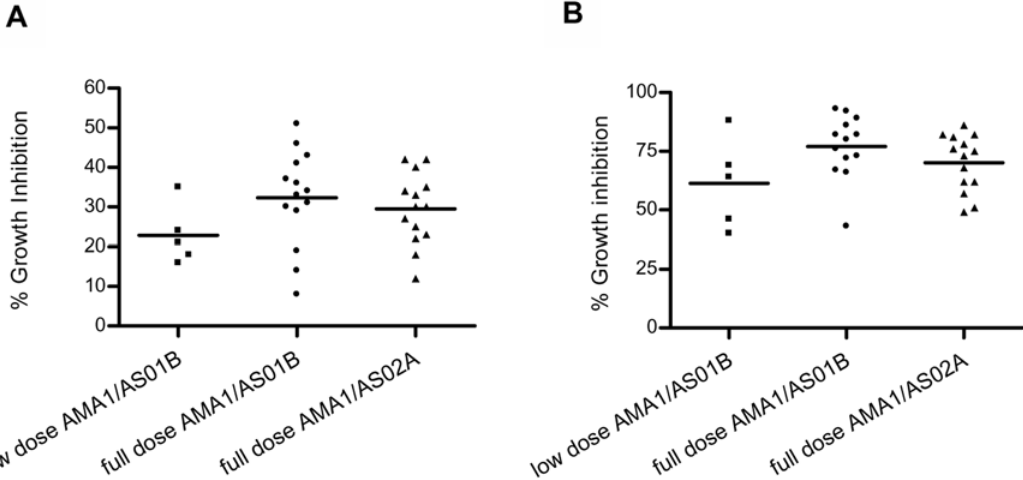
Figure 3. Mean percent growth inhibition activity of 3D7 parasites by GIA. (A) WRAIR 20% serum pLDH GIA (B) NIH pLDH GIA at 4 mg/mL purified immunoglobulin. Results expressed as mean percent inhibition with serum from Day 70 using GIA methods described in Outcomes section. Low dose AMA-1/AS01B (n=5), full dose AMA-1 in AS01B or AS02A (n=14 in each).